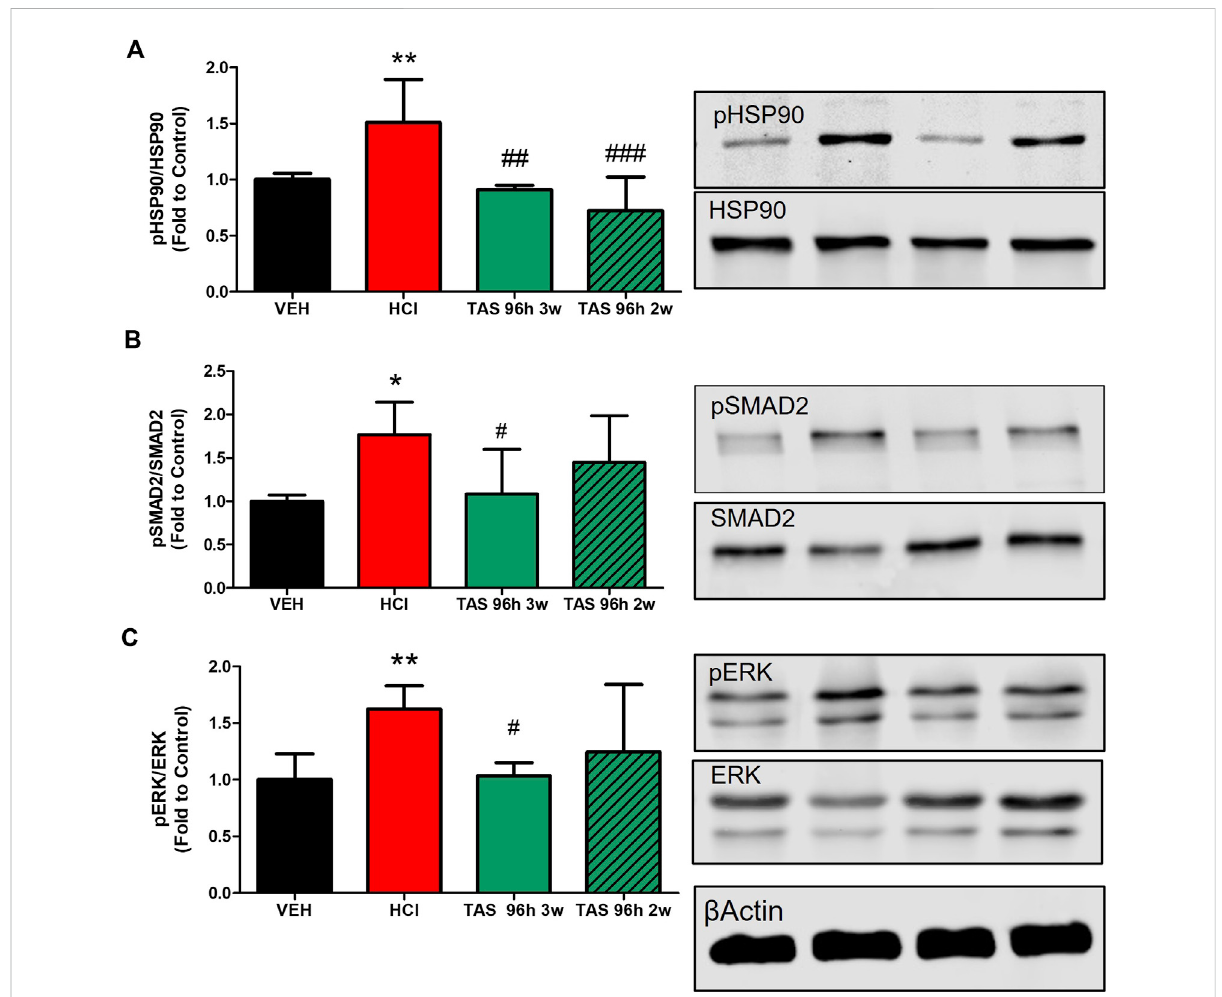
3 weeks treatment with TAS-116 ameliorates HCl-induced activation of pro- fi brotic pathways. (A) Heat Shock Protein 90 activation (pHSP90) increased in HCl-instilled mice and was reduced in mice, treated for 2 or 3 weeks with TAS-116, starting 96 h post HCl. (B) Active (phosphorylated) SMAD2 and (C) ERK1/2 were signi fi cantly increased in mice instilled with HCl and reduced in mice, treated for 3, but not 2 weeks with TAS-116. Means ± SEM; **: p < 0.01, *: p < 0.05 from VEH; # : p < 0.05, ## : p < 0.01, ### : p < 0.001 from HCl, with one-way ANOVA and Tukey ’ s post-hoc test, n = 5 –